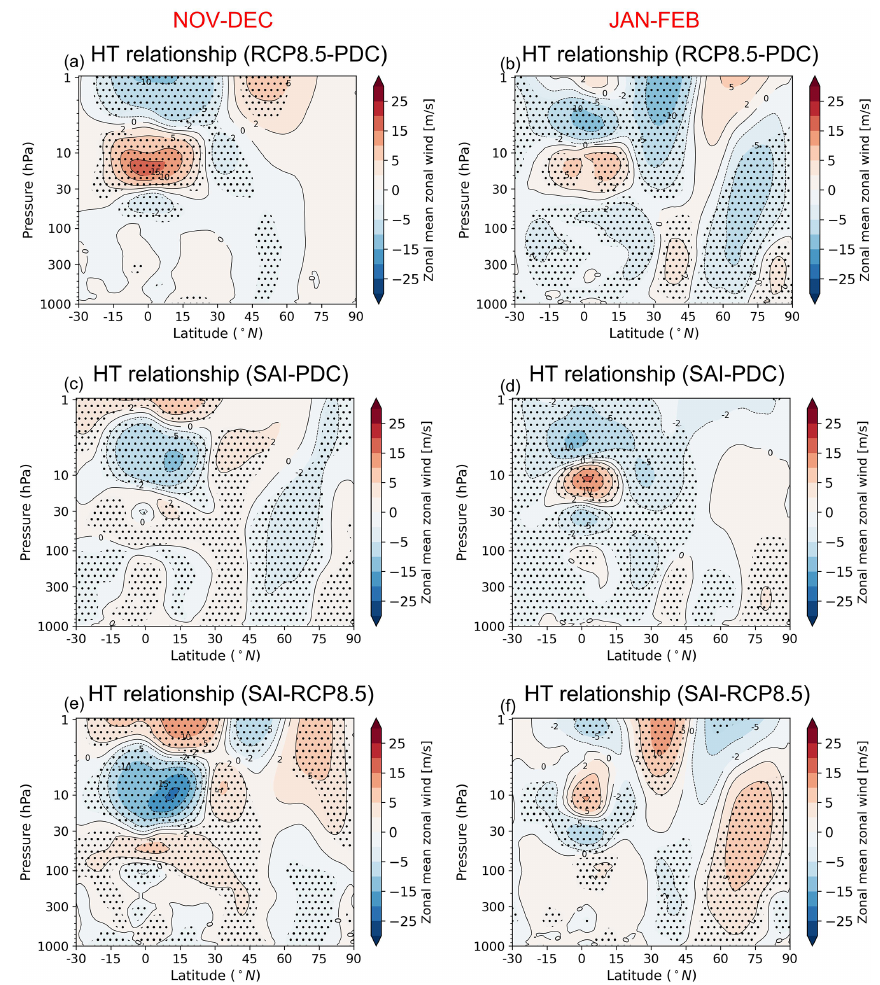
Figure 5. Changes in the HT relationship (for zonal-mean zonal wind) under SAI and global warming (RCP8.5) scenarios compared to the